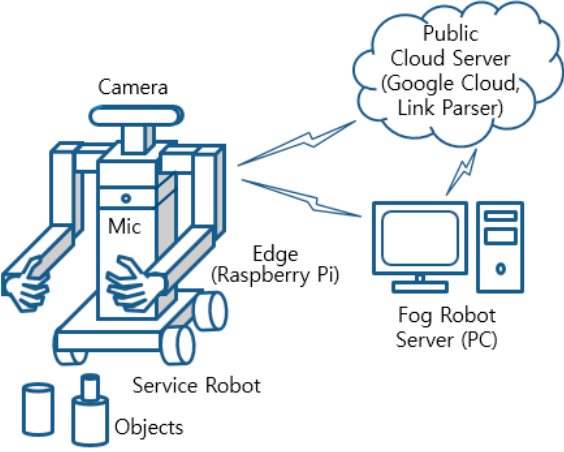
Figure 6. The schematic of the FaaS-FR service implementation with an edge of low computing power.